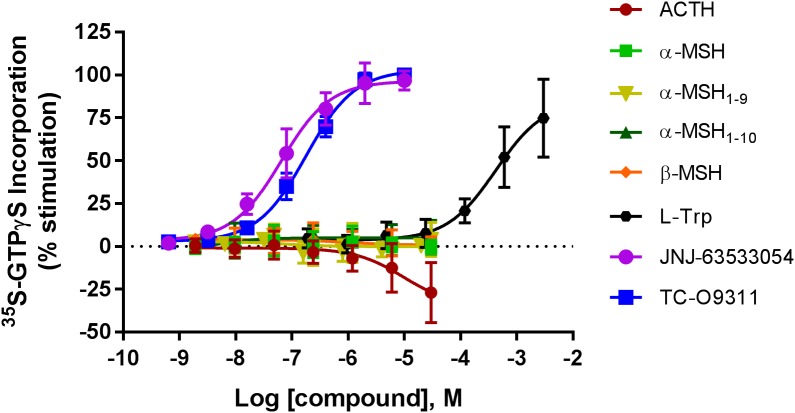
Concentration response curves of ACTH, α-MSH, α-MSH1-9, α-MSH1-10, β-MSH, L-Trp, JNJ-63533054, and TC-O9311 on [35S]GTPγS binding in CHO-TREx cells stably expressing human GPR139. Data are the mean ± SEM of at least three separate experiments performed in triplicates. Response normalized to buffer and EC100 of JNJ-63533054.